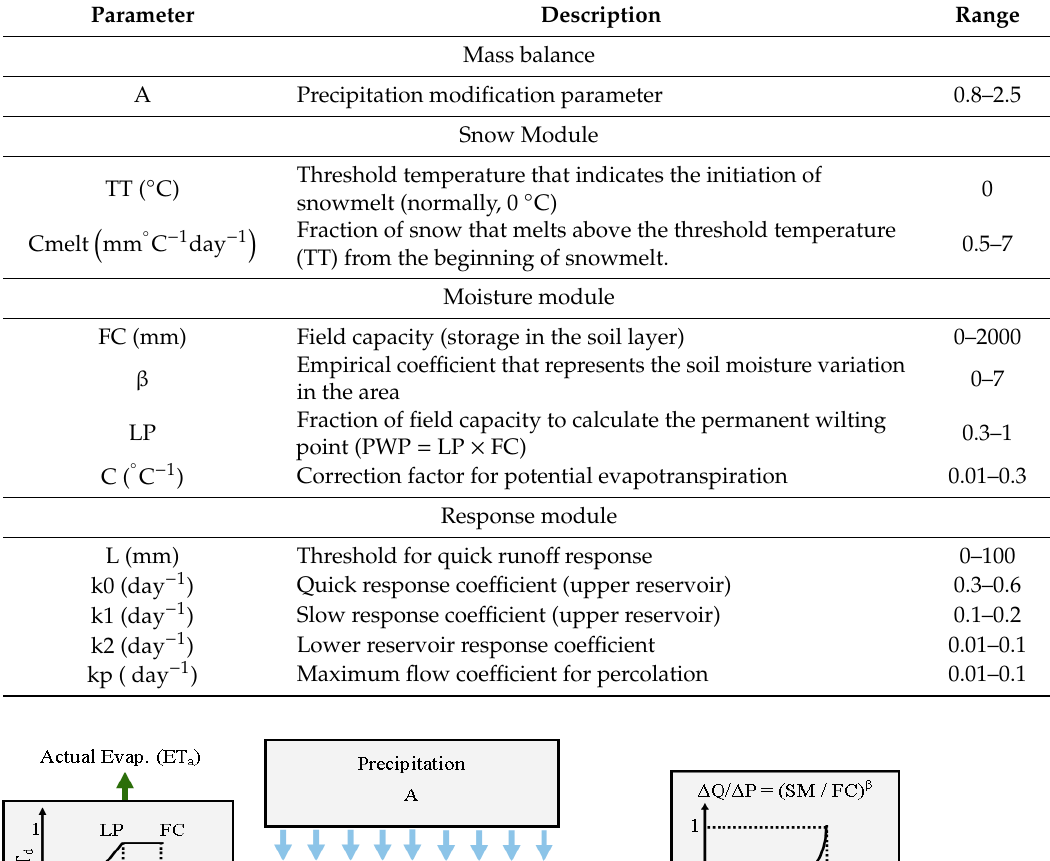
Table 1. Model parameters and initial ranges used for the analysis.